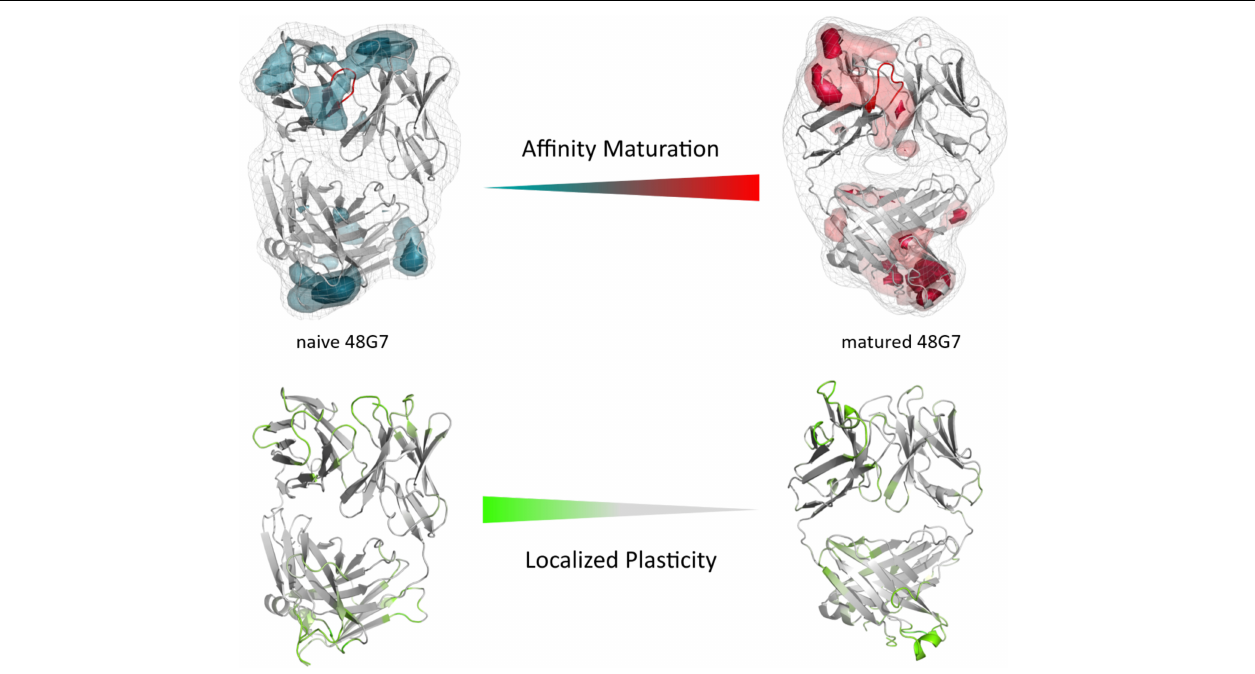
FIGURE 7 | Global (top) and localized (bottom) surface plasticity of the naive and matured 4G87 antibody Fab mapped onto a representative ensemble structure. (Top) Global plasticity of the naïve and the matured 48G7 antibody, highlighting the CDR-H3 loop in red. The intensity of the colors reflects the regions with higher plasticity and allows localization. (Bottom) Localized plasticity for both the naïve and the matured 48G7 antibody,